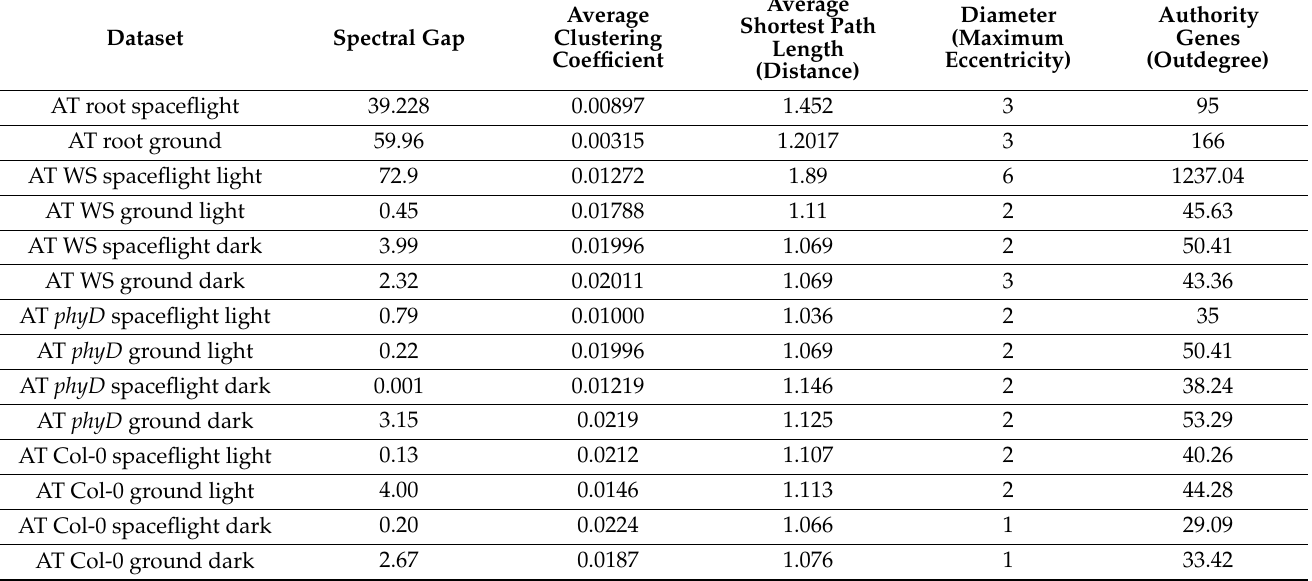
Table 3. Topological and spectral analysis for Arabidopsis (AT) spaceflight and ground gene regulatory networks.